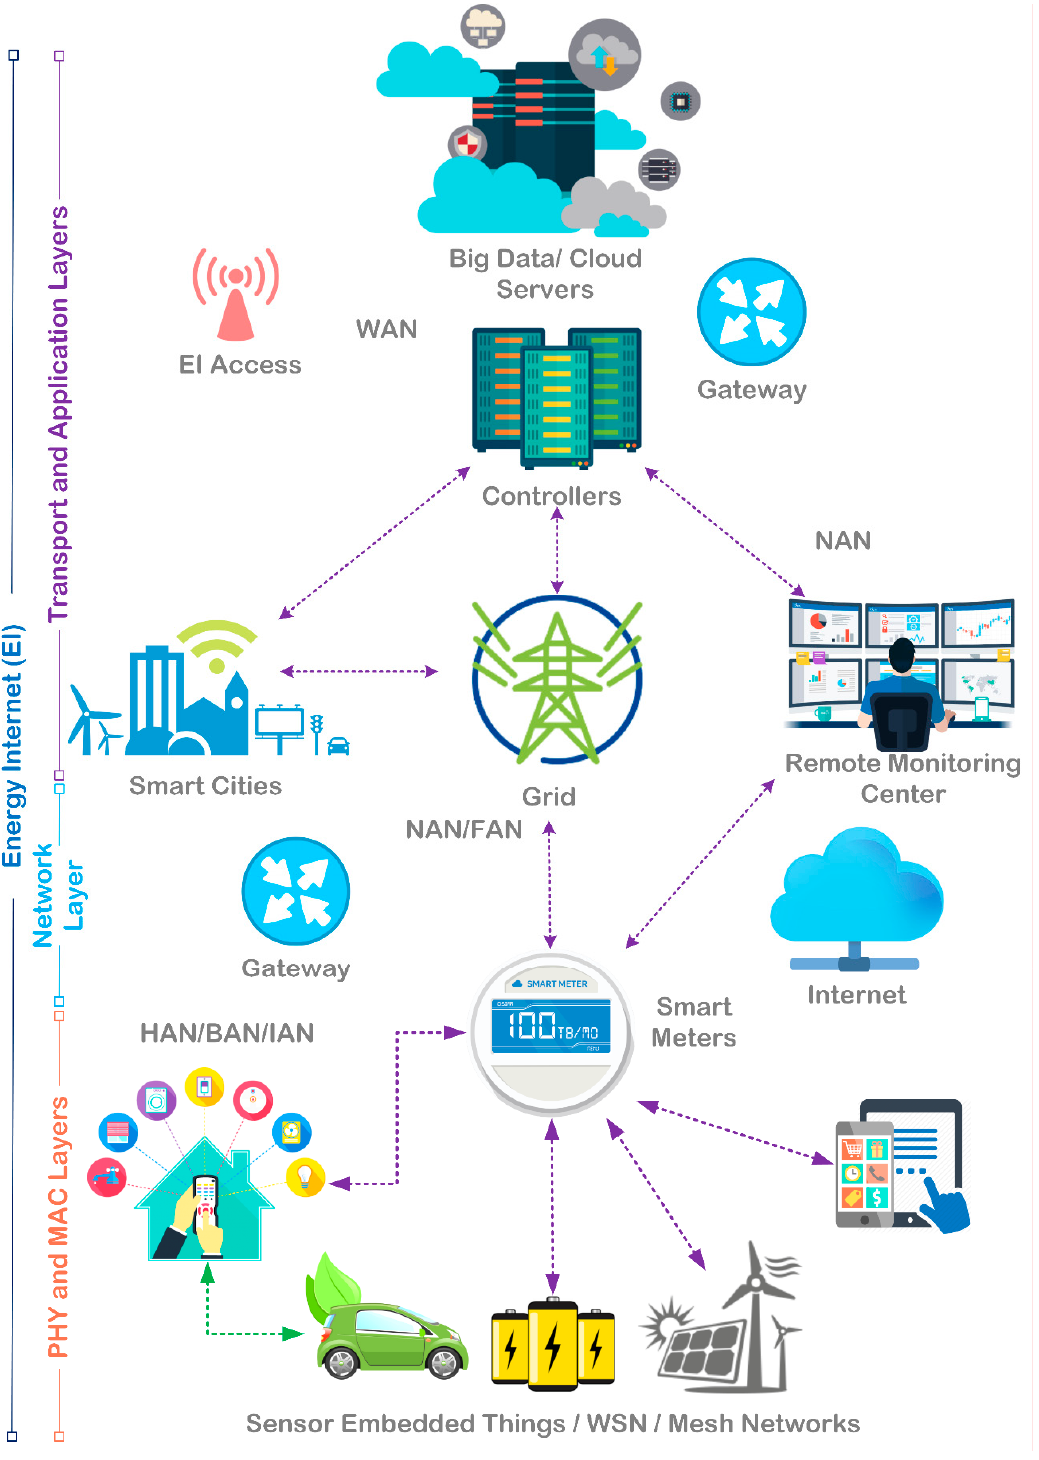
Figure 2. Interaction of Internet of Things (IoT) applications with the Energy Internet (EI) concept.